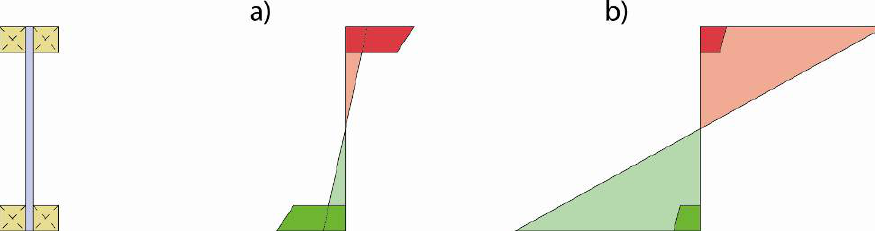
Figure 4: Flexural stress distribution: a) wood PMMA composite, b) wood glass composite.